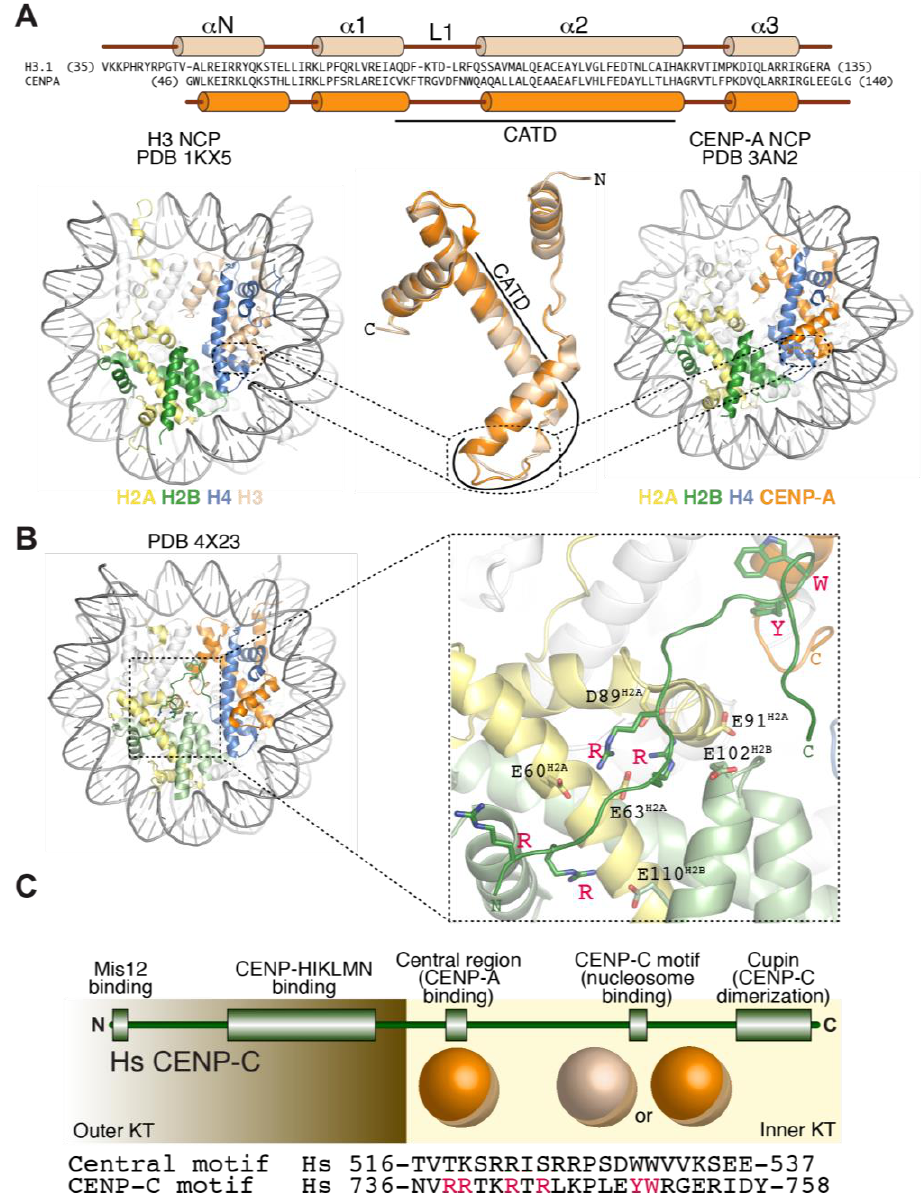
Figure 3. The CENP-A nucleosome and its specific recognition by CENP-C. ( A ) Comparison of H3 and CENP-A primary, secondary, tertiary, and quaternary structure. Sequence and structure changes concentrate in the N-terminal region, in the L1 segment of the CATD, and in the C-terminal region; ( B ) Structure of the complex of the CENP-C motif bound to a nucleosome containing a chimeric histone H3 with grafted hydrophobic C-terminal peptide of CENP-A [79]; ( C ) Scheme illustrating the organization of CENP-C as a “blueprint” for kinetochore assembly along the outer to inner kinetochore axis [80]. The H3 nucleosome structure is from X. laevis , the CENP-A nucleosome structure is human, and the CENP-C motif-bound structure has a Drosophila nucleosome core particle (in which the human CENP-A tail was grafted onto H3) bound to a rat CENP-C